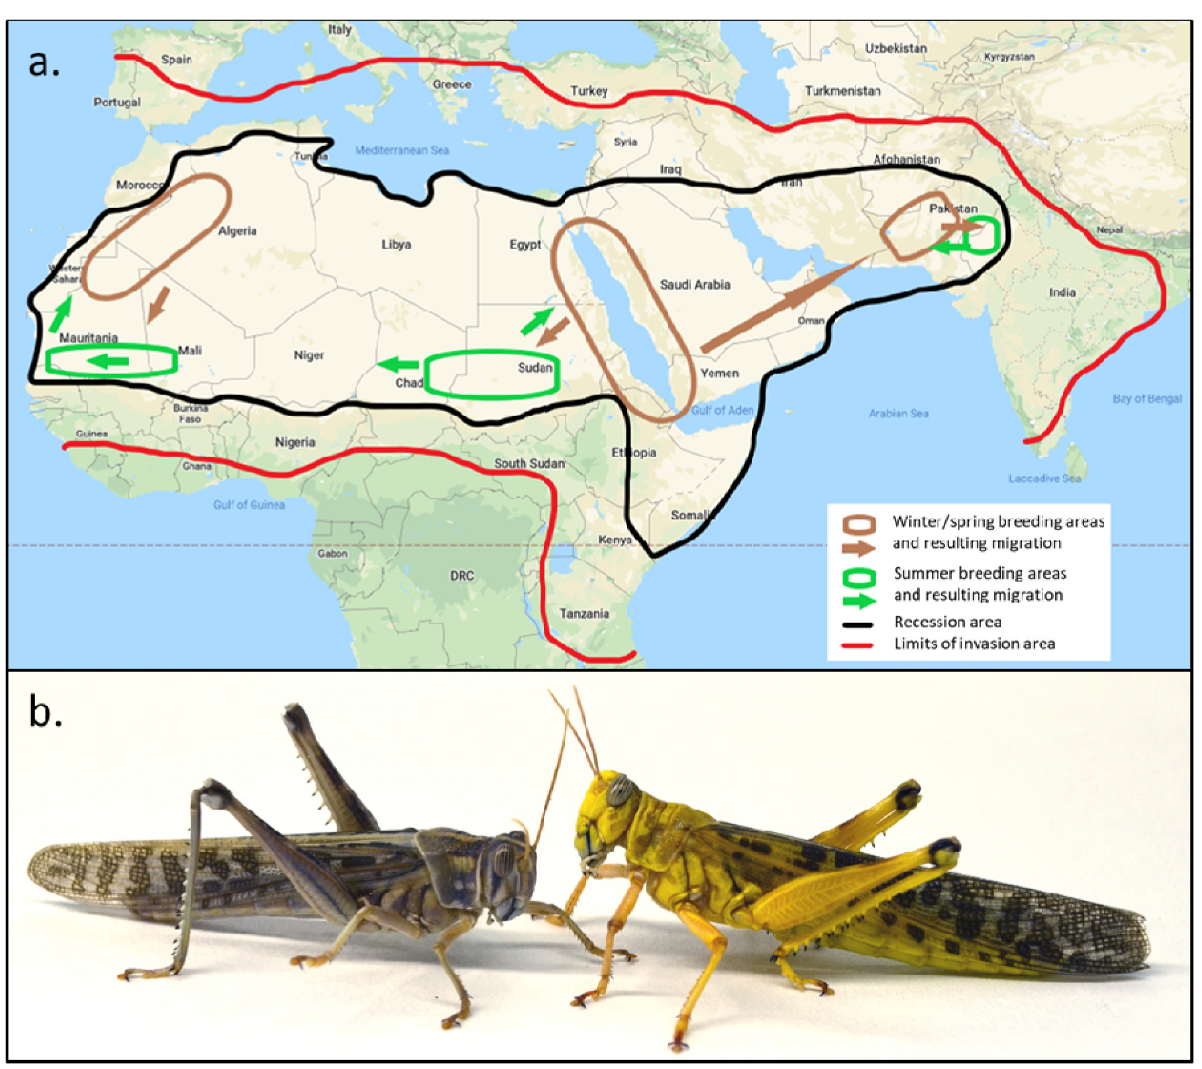
Figure 1. Geographical distribution of the desert locust and a picture of two adult male desert locusts, one in the solitarious phase and the other in the gregarious phase. ( a ) Geographic distribution of the desert locust. During ‘recession’ periods, desert locusts are restricted to the semi-arid and arid regions of Africa, the Arabian Peninsula and South-West Asia that receive less than 200 mm of annual rain. The recession area covers about 16 million km 2 in 30 countries. Within this recession area, locusts move seasonally between winter/spring and summer breeding areas. During outbreaks, desert locusts may spill into more fertile adjacent regions, threatening an area of some 29 million km 2 comprising 60 countries as outbreaks escalate into upsurges and further into plagues. The recession breeding areas and migration patterns may have predictive value to understand how the swarms will migrate Range of the non-swarming southern sub-species S. gregaria flaviventris not shown. Figure based on information from FAO Locust Watch (Cressman, 2016; Symmons & Cressman, 2001), map derived from Google Map Data ©2020 Google. ( b ) Phase polyphenism in desert locusts, using the example of sexually mature males. The gregarious male (right) is brightly coloured, while the solitarious male relies on camouflage colours. In this staged scene, the solitarious male was forced into close proximity of the gregarious male and is seen retreating from its conspecific. Photo by H. Verlinden and R.